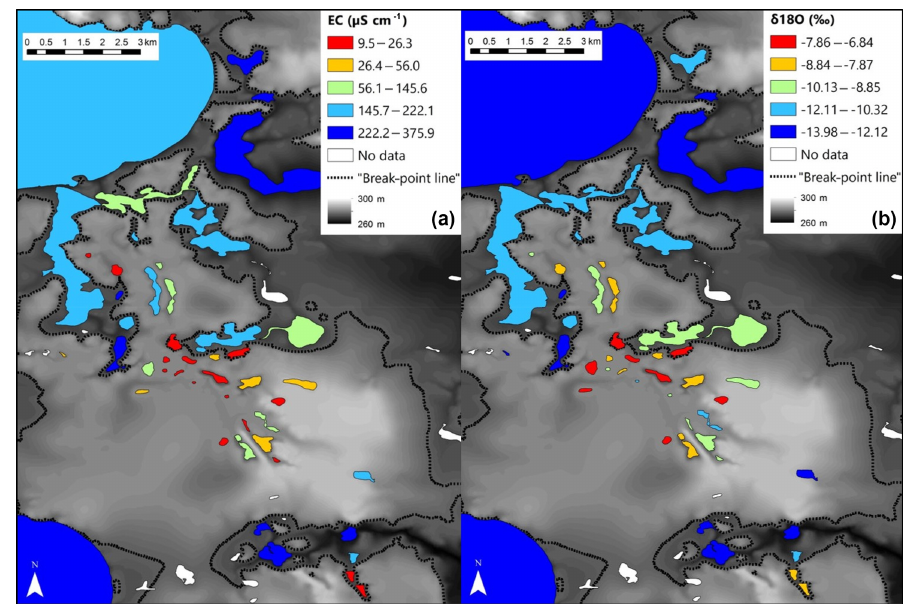
Figure 5. Spatial depiction between elevation and lake-water-specific conductance (µScm − 1 ) (a) and lake-water δ 18 O (‰) (b) . The elevation of the breakpoint line (284m) is shown as a dashed